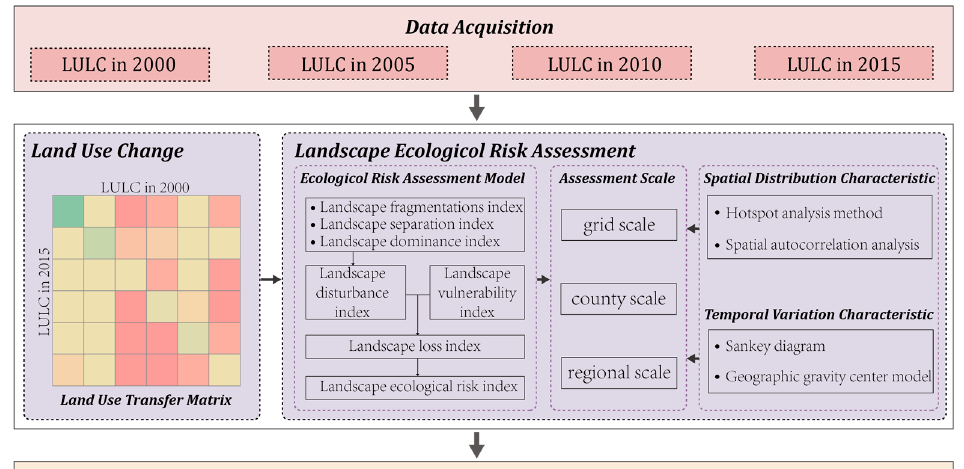
Figure 3. The workflow of the research.